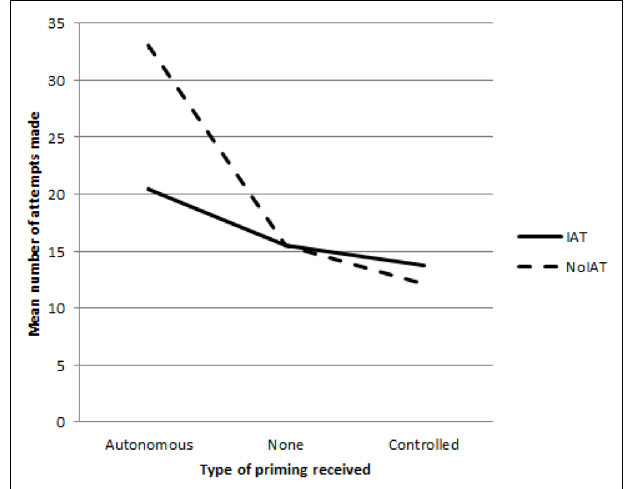
FIGURE 1 | Graph showing the interaction of IAT completion and priming manipulation on number of attempts on a figure-tracing task.